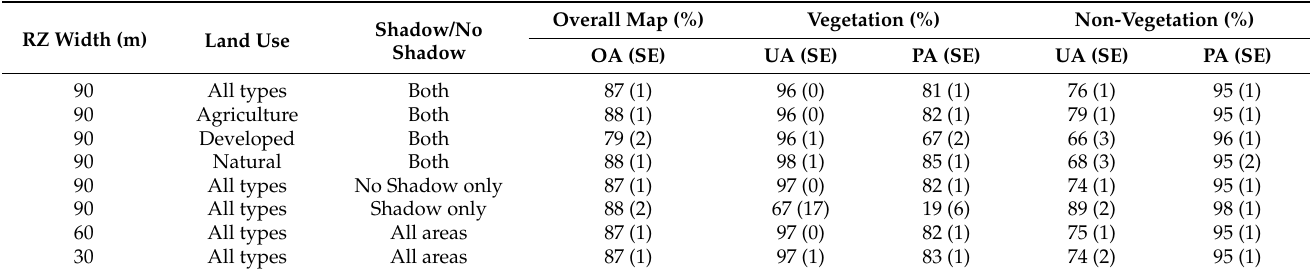
Table 3. Riparian vegetation classification accuracy of riparian zone along Genesee River characterized by land use and image shadow presence (full confusion matrices are provided in Table